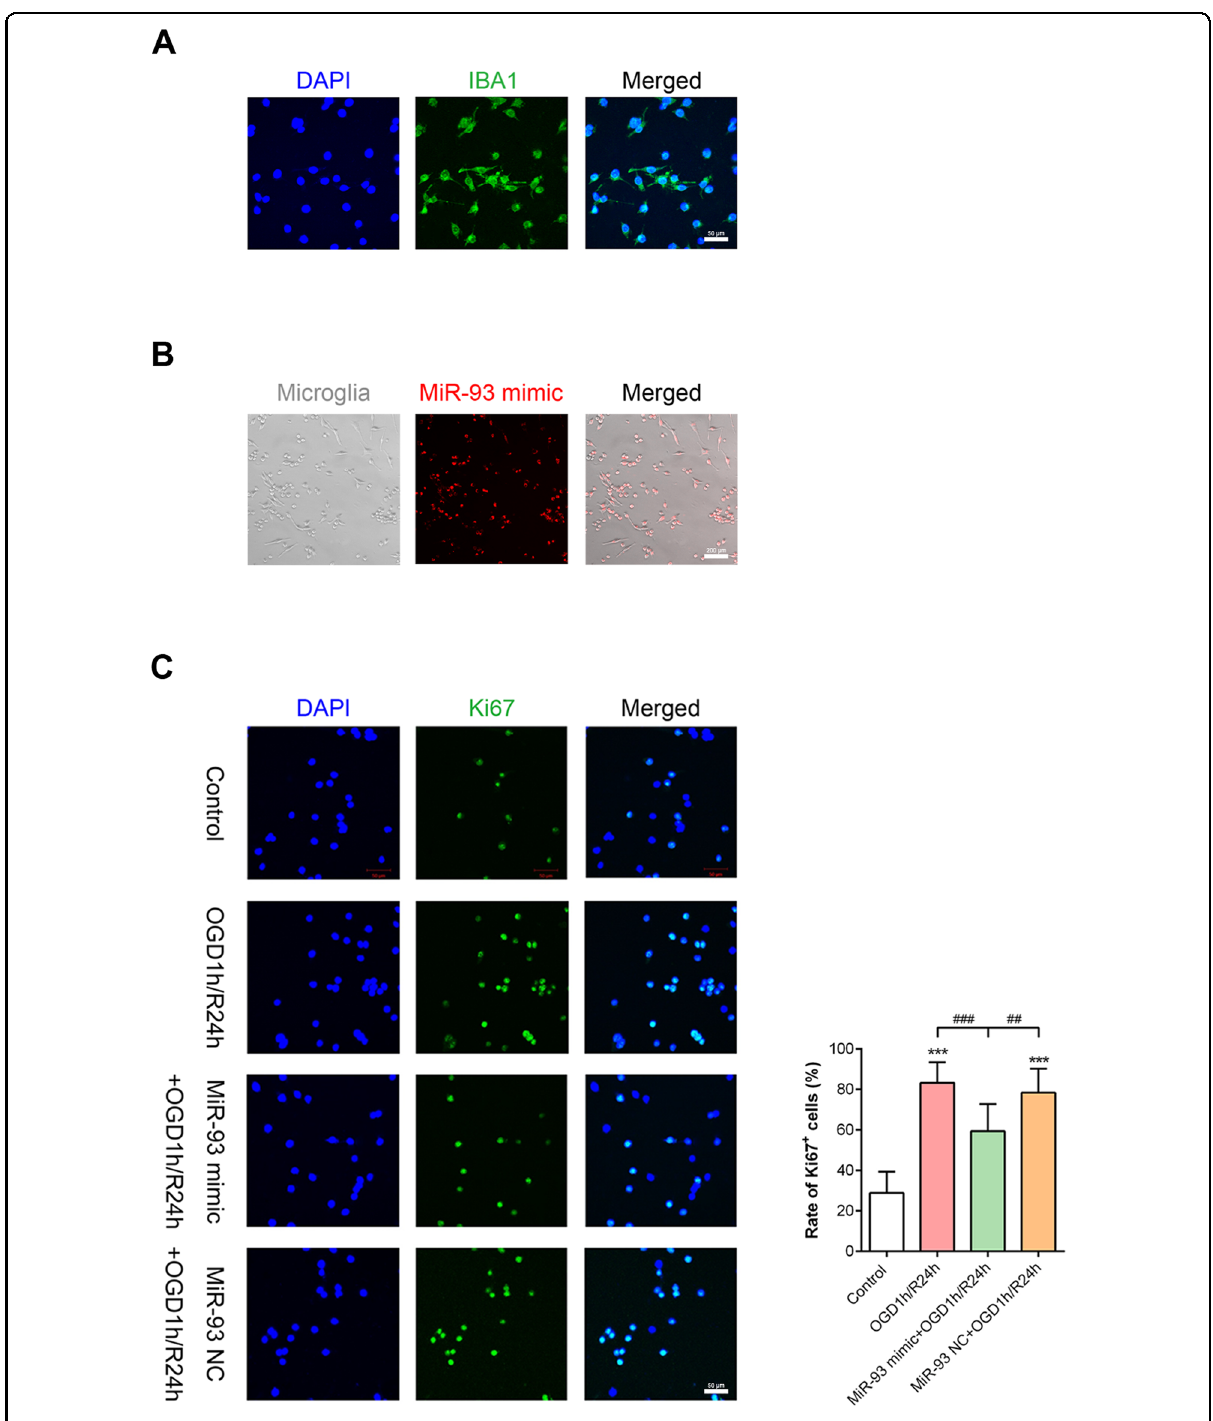
Fig. 4 Overexpression of miR-93 inhibited microglial proliferation after OGD1 h/R24 h. A Cultured cells were microglia, as identi fi ed by IBA1 +